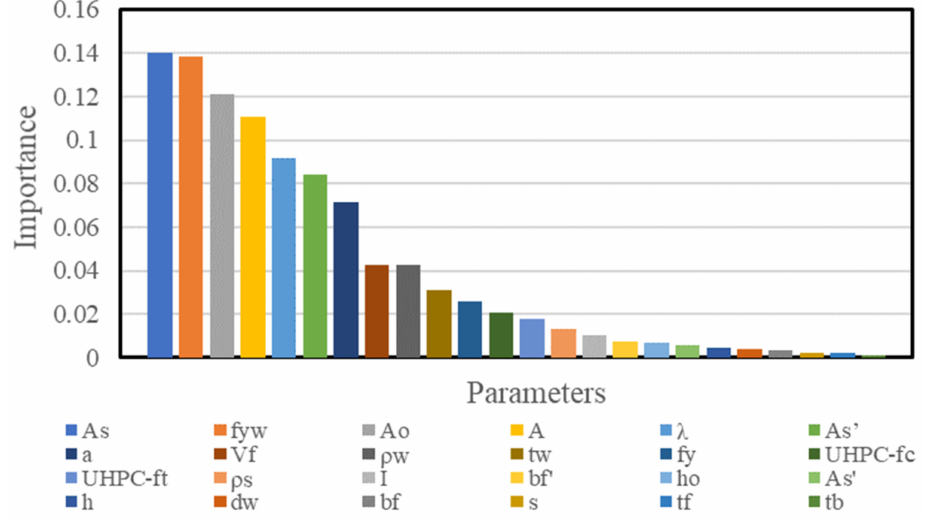
Figure 3. The influence importance of various parameters on the shear strength of UHPFRC